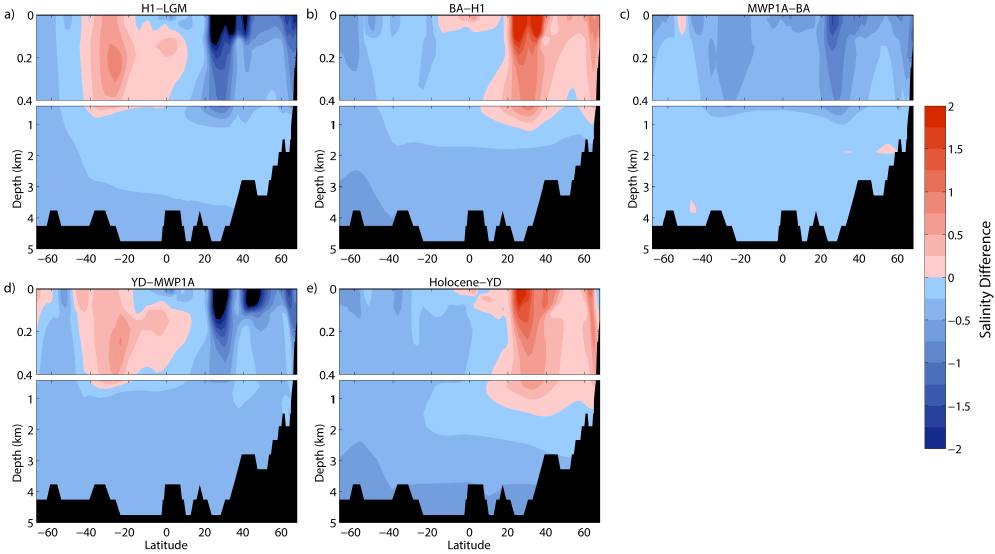
Figure 7. TraCE-21K salinity differences between (a) H1 (19ka–14.67ka) and LGM (22ka–19ka); (b) BA (14.67ka–14.35ka) and H1 (19ka–14.67ka); (c) MWP-1A (14.35ka–13.85ka) and BA (14.67ka–14.35ka); (d) YD (12.9ka–11.3ka) and MWP-1A (14.35ka– 13.85ka); (e) Holocene (11.3ka–0ka) and YD (12.9ka–11.3ka).